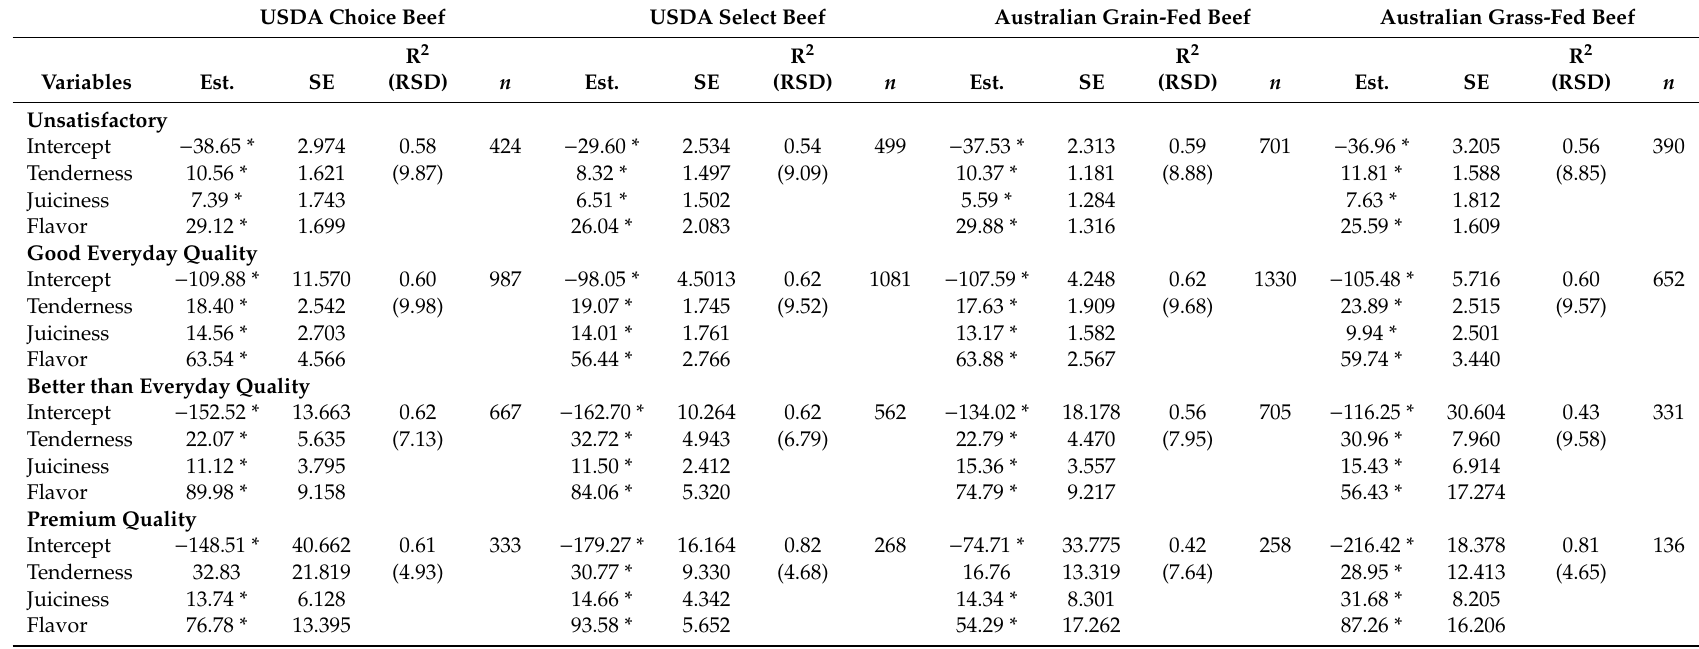
Table 5. Comparison of attribute intensity within di ff erent